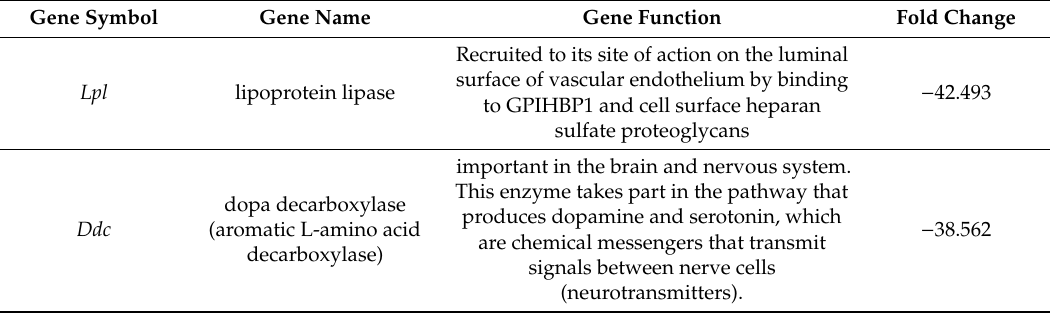
Figure 3. The bubble plot with changed pathways assigned according to the KEGG Pathway Database in bortezomib-treated PC12-derived nerve cells compared to the control cells. Genes assigned to individual processes fulfilling the criteria: Adjusted p < 0.05, method = Benjamini, and minimum number of genes per group = 5, are presented. The bubble size indicates the number of genes represented in the corresponding annotation. Table 1. The list of 15 the most downregulated genes in bortezomib-treated PC12-derived nerve cells compared to